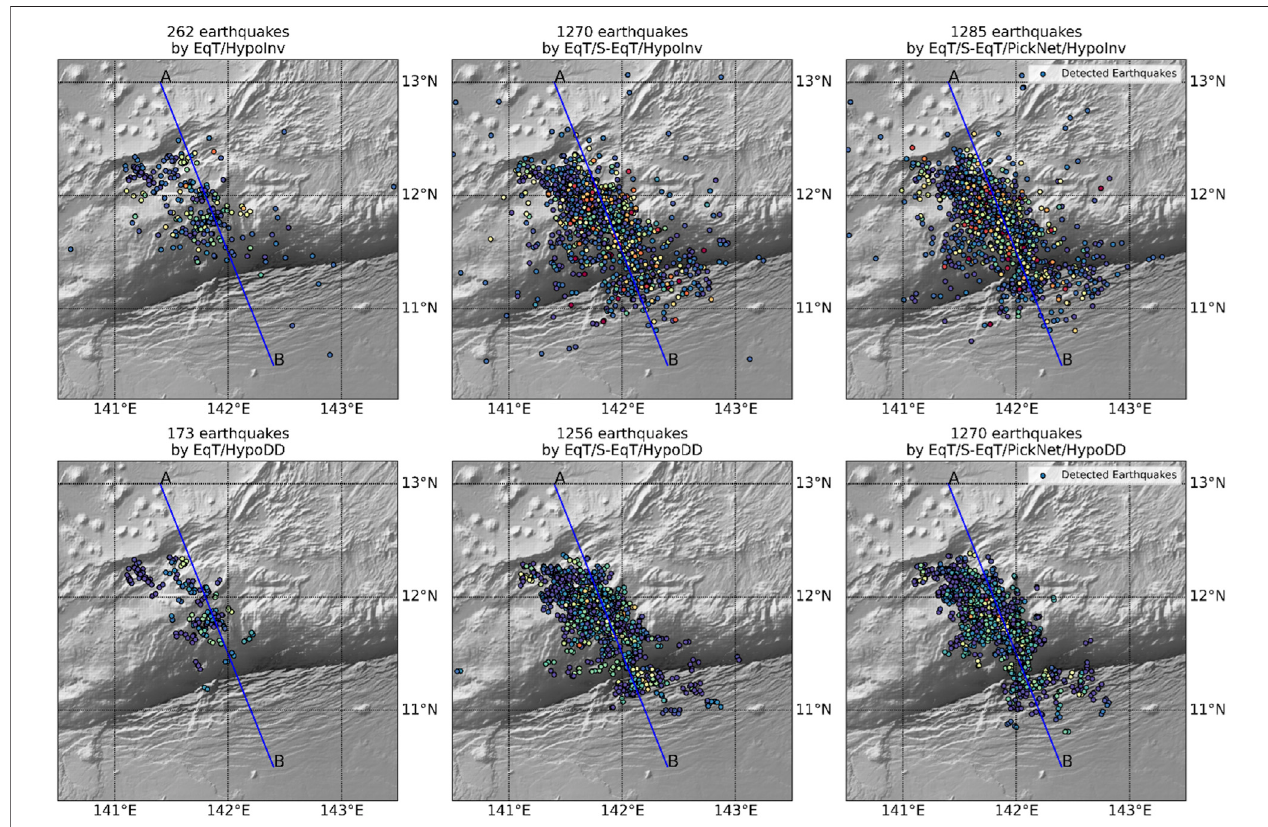
FIGURE 3 | Comparison of location results. (A – C) plot relocation result by of EqT only, both EqT and S-EqT, and the full process of ESPRH (EqT, S-EqT, and PickNet), respectively. In the same way, (D – F) plot absolute location results. Seismic events are plotted in dots, with their depth coded by color. Reference locations of sections Panel 5 are plotted in blue